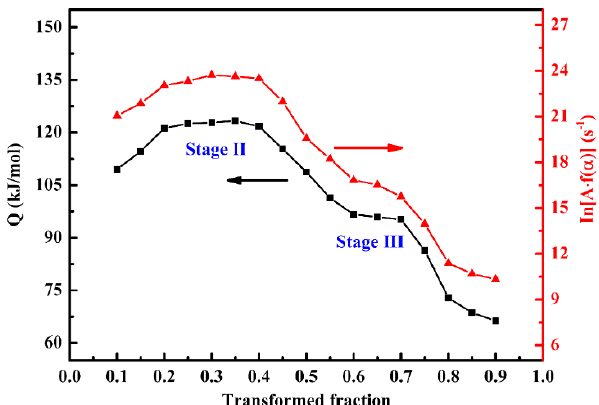
Figure 5. The activation energy and modified pre-exponential factor with respect to the transformed fraction.